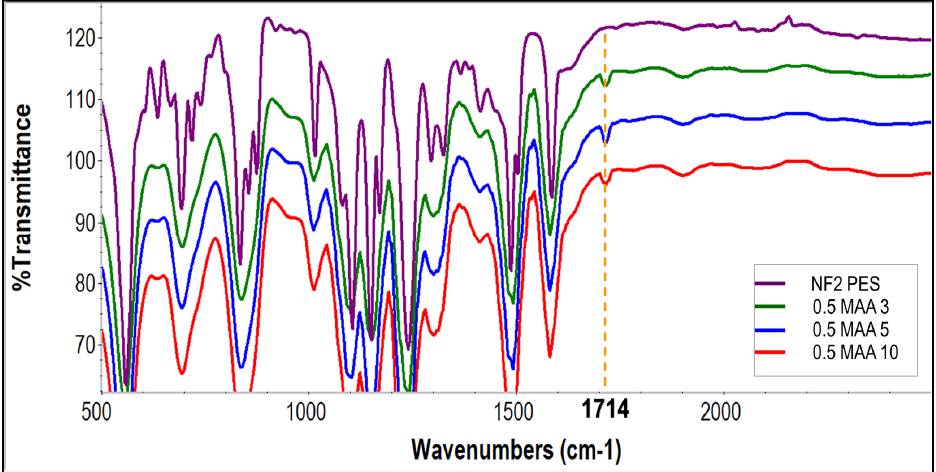
Figure 5. UV − photochemical grafting modification of polyether(sulfone) with methacrylic acid.